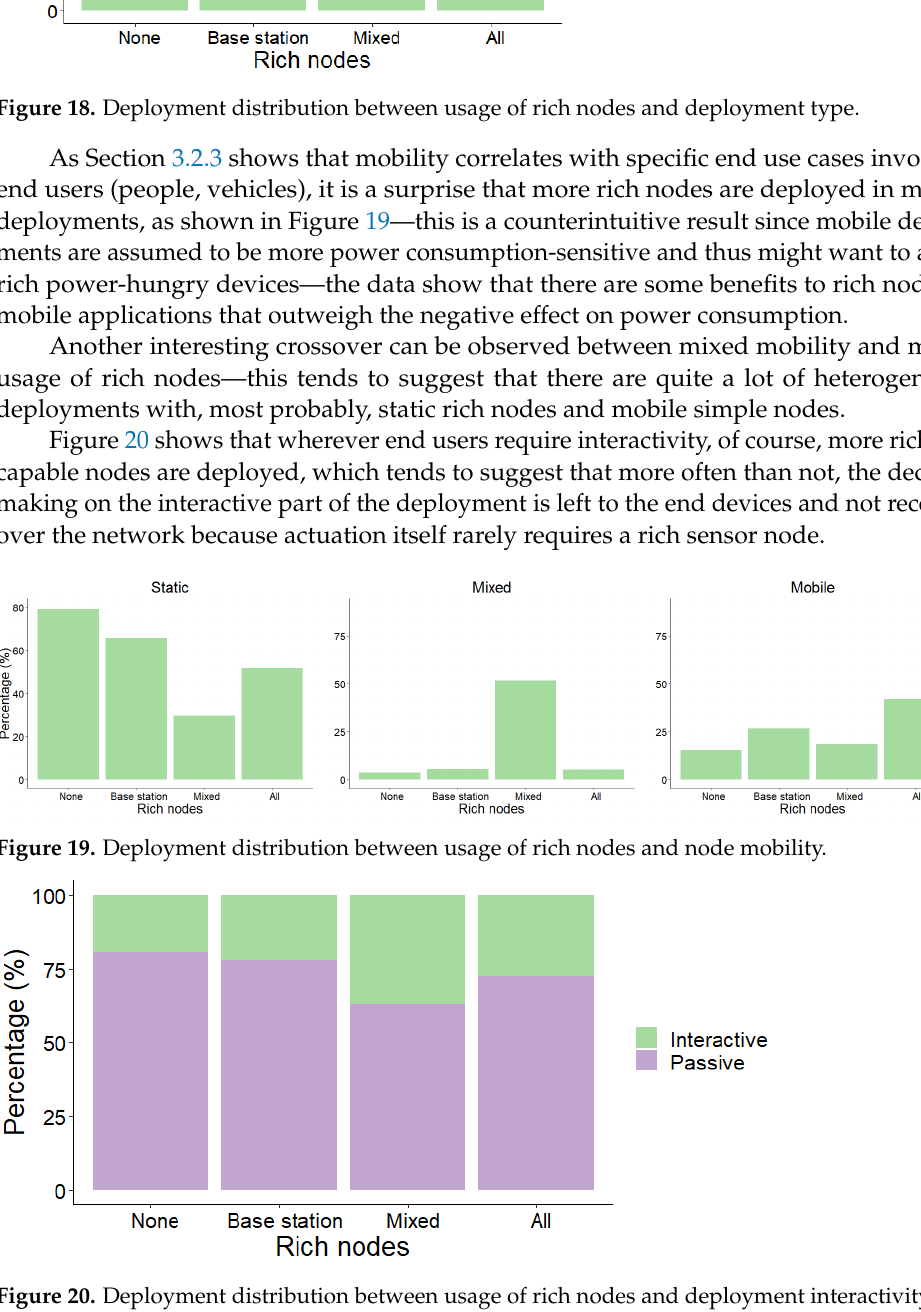
Figure 20. Deployment distribution between usage of rich nodes and deployment